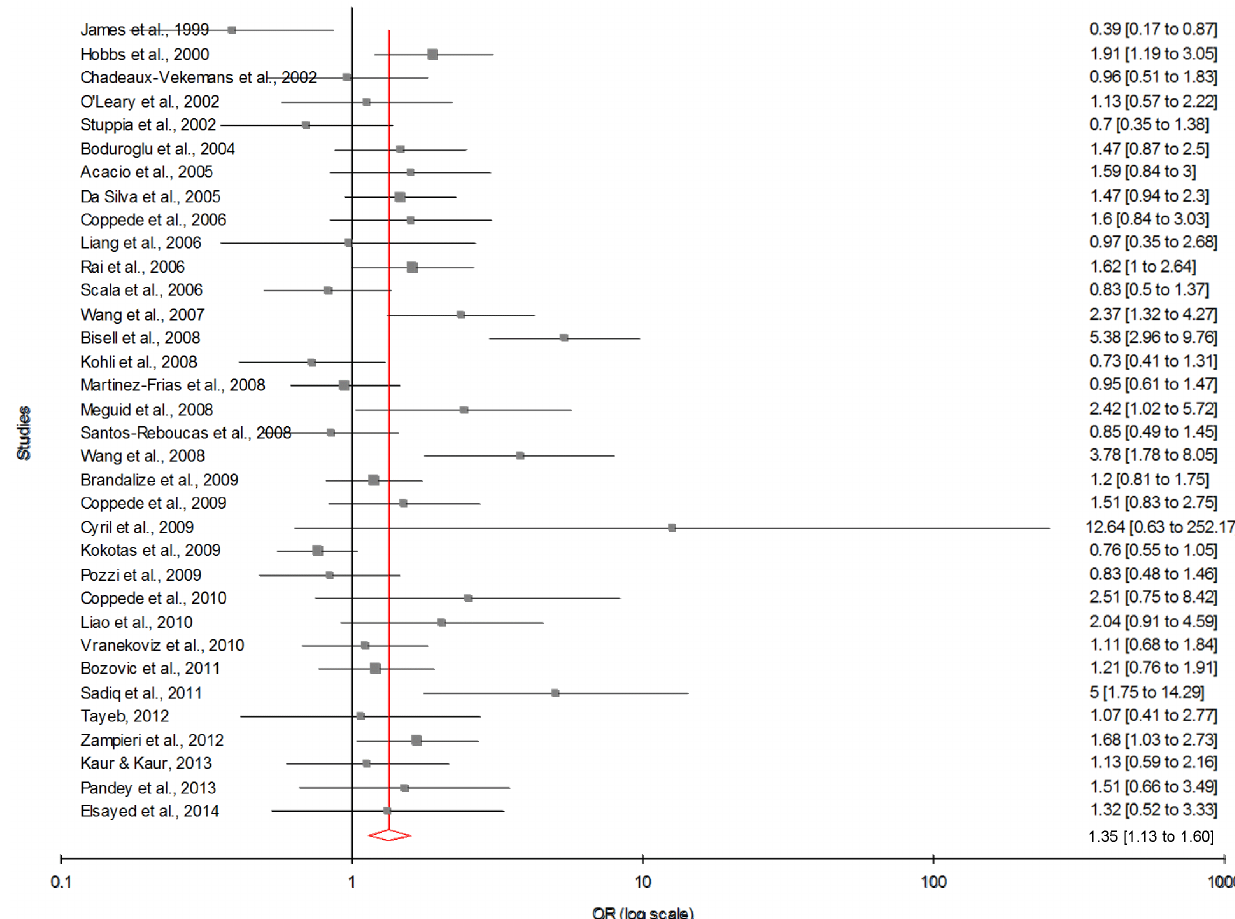
Figure 4. Forest plots (Random effect) showed significant association between MTHFR C677T polymorphism and risk of Down syndrome using dominant model (TT + CT versus CC). Results of individual and summary OR estimates and 95% CI of each study were shown.